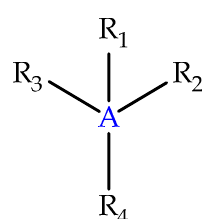
Figure 20. Formula IV for the novel molecules developed in the patent.